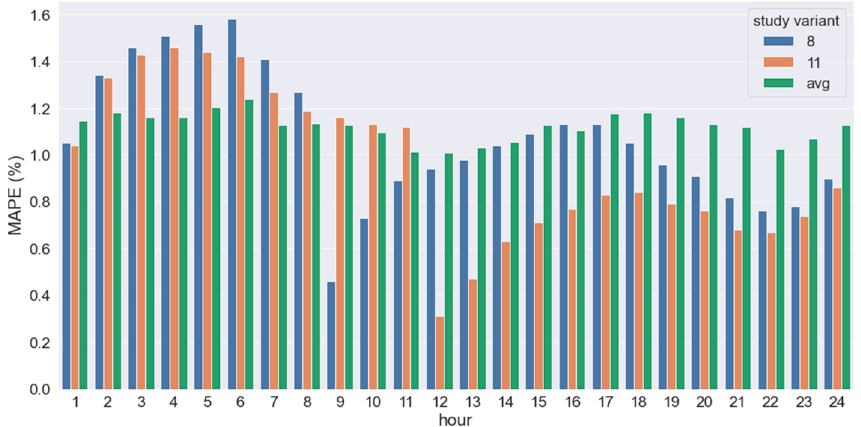
Figure 19. Comparison of hourly energy demand profile excluding EV between our study averaged profile and profiles started to be predicted at 8/11